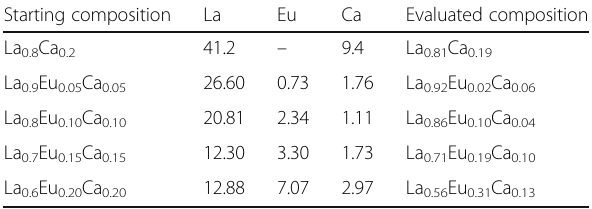
Table 1 Calculated starting composition of the La, Ca, and Eu atoms in the samples under synthesis, average content of atoms (in at.%), and evaluated composition of the synthesized samples Starting composition La Eu Evaluated